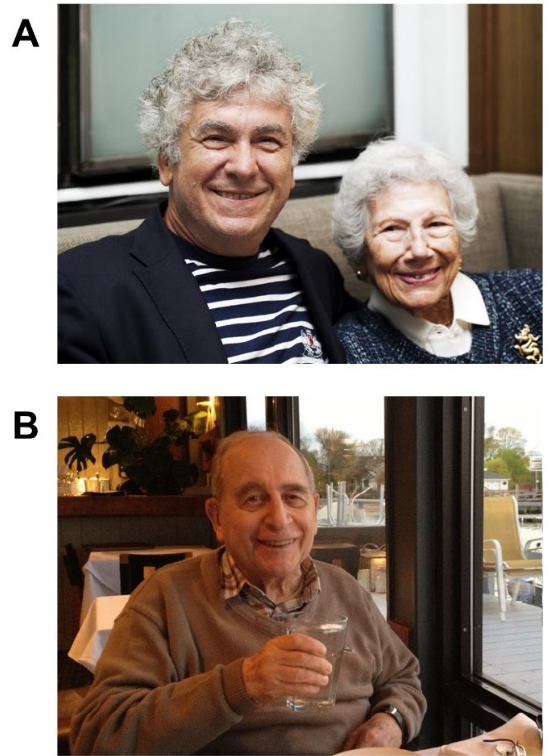
Figure 1. ( A ). Miro Radman (left) with Evelyn Witkin (right) in Paris, 2012. ( B ). Raymond Devoret à pris dîner à Sage Grill & Oyster Bar, New Haven, CT, 2013.